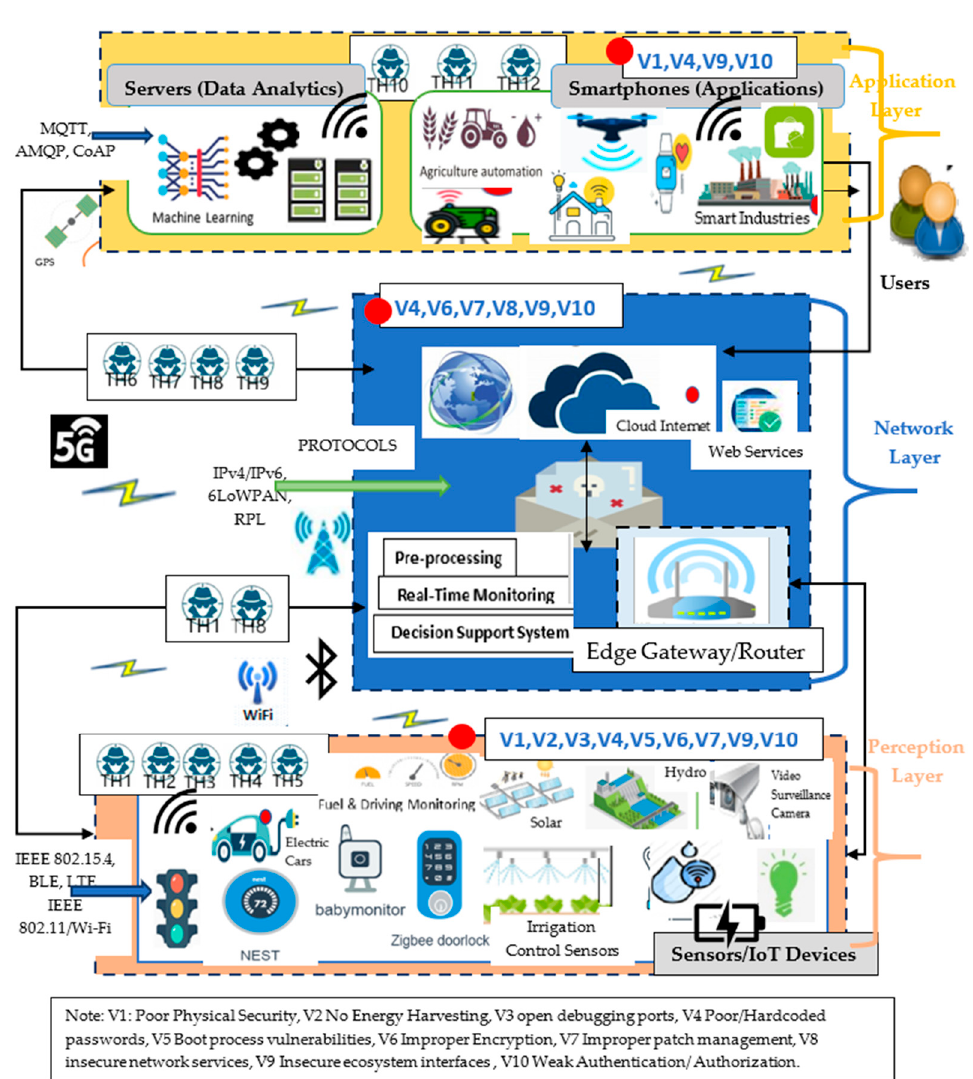
Figure 4. Threat Architecture of Internet of Things.